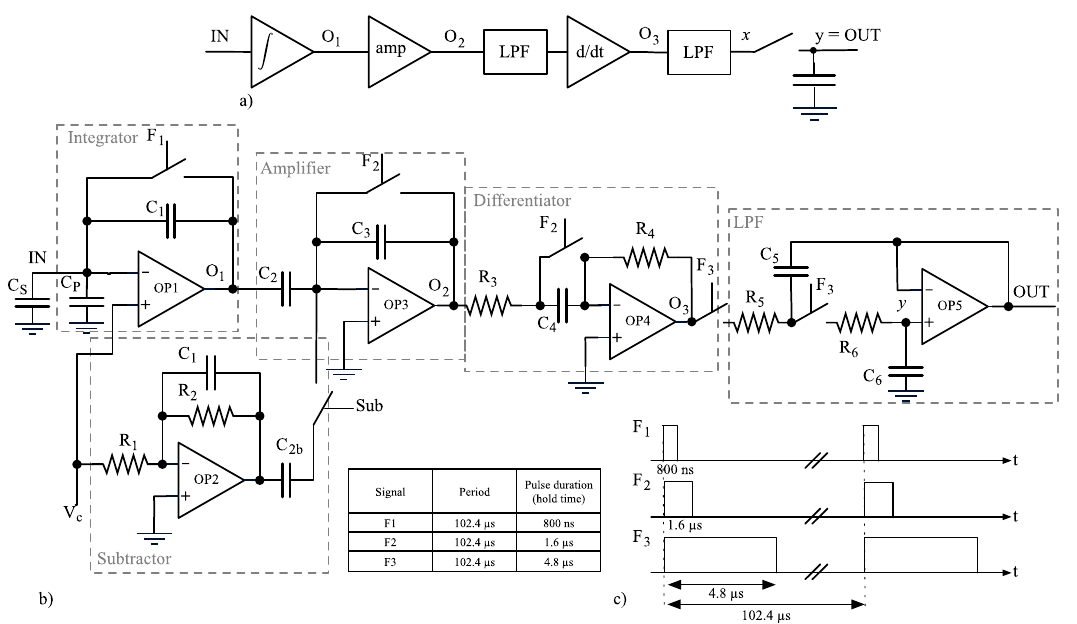
Figure 5. ( a ) Block scheme of the proposed frontend. The signal direct path is composed of integrator, voltage amplifier, differentiator and active LPF; ( b ) Full schematic diagram of the frontend, where a subtractor has been added to eliminate derivative component of stimulus signal from the final output. This subtractor stage can be activated/deactivated using the control signal Sub; ( c ) Timing behavior of signals F1, F2 and F3.